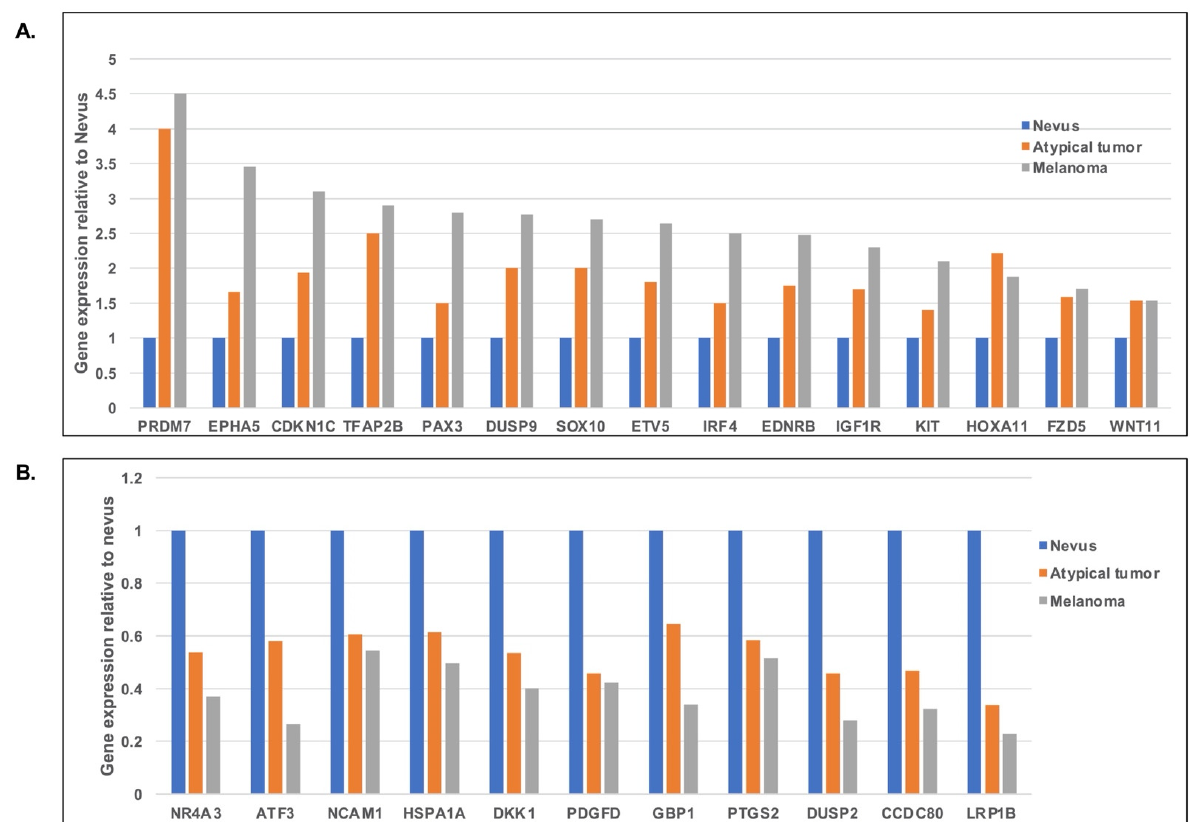
Figure 3. ( A ) Relative expression levels of the genes showing the upregulated trend of expression from nevus, atypical tumor to melanoma. ( B ) Relative expression levels of the genes showing the downregulated trend of expression from nevus, atypical tumor to melanoma.